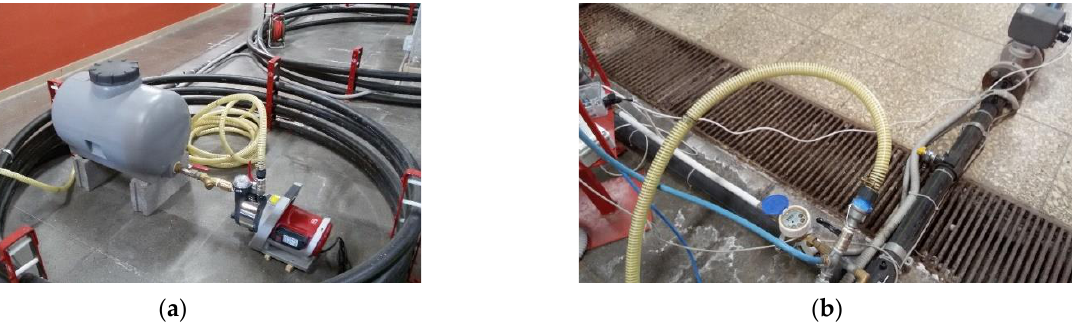
Figure 3. Installation of the pump-reservoir system ( a ) and connection to the node ( b